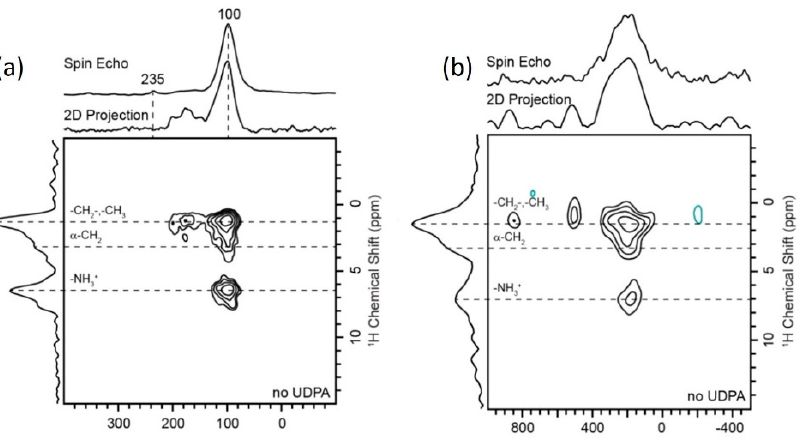
Figure 5. ( a ) 133 Cs spin echo and 2D 1H → 133 Cs CP-HETCOR NMR spectra of CsPbBr 3 QDs without UDPA; ( b ) 207 Pb spin echo NMR spectra and 2D 207 Pb → 1H CP-HETCOR of CsPbBr 3 QDs without UDPA. Reprinted with permission from ref. [101]. Copyright 2020 American Chemical Society.